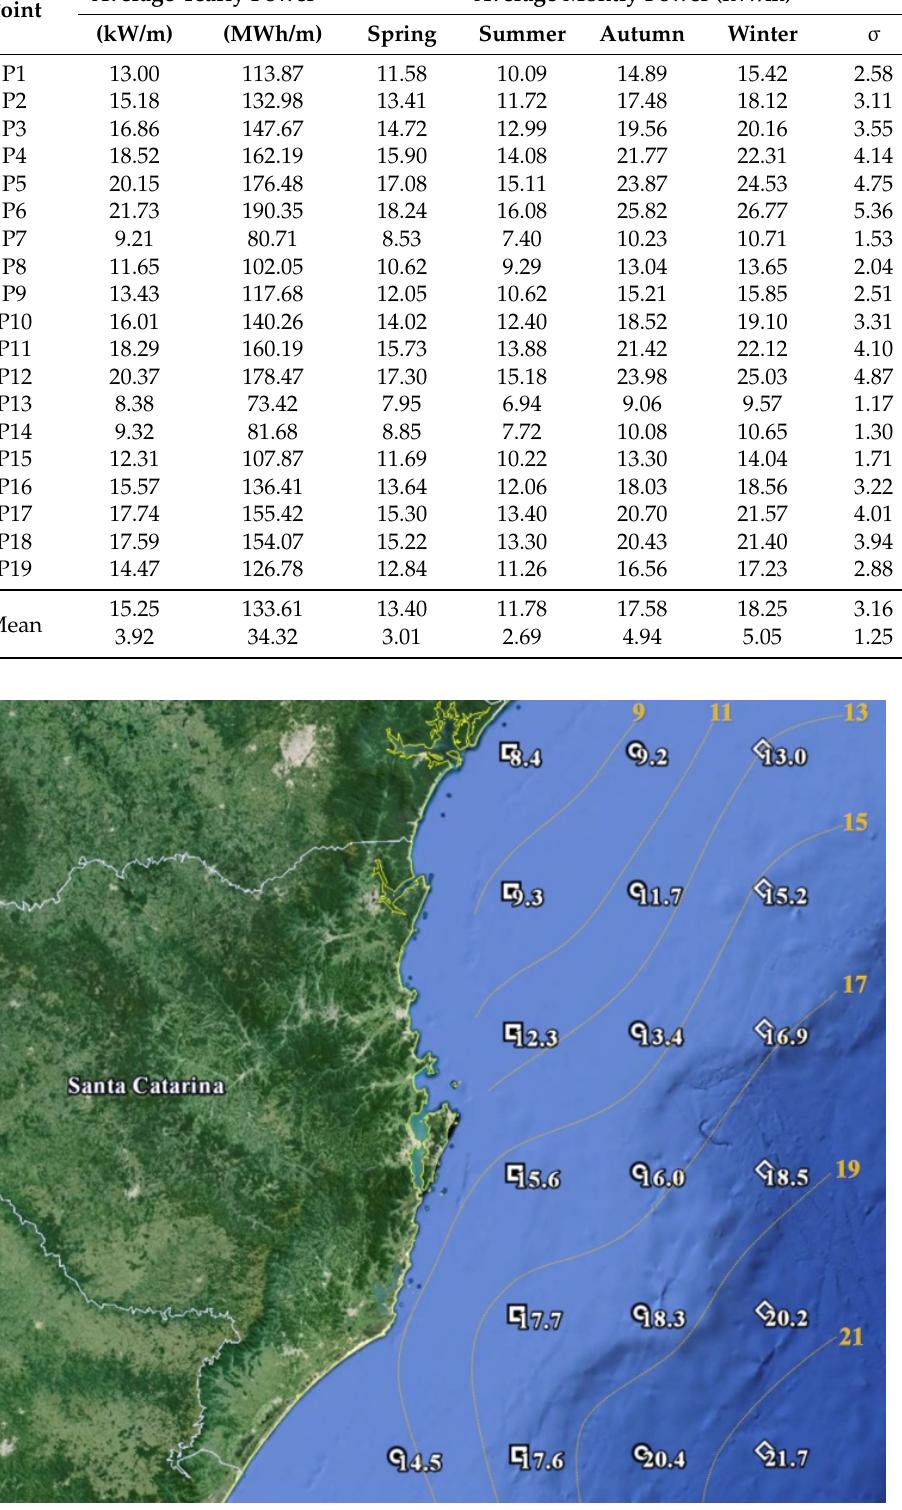
Table 3. Average seasonal and yearly wave power (based on 10 ‐ year average) at ECMWF grid points. Average Yearly Power Average Montly Power (kW/m) Point (kW/m) (MWh/m) Spring Summer Autumn σ P1 P2